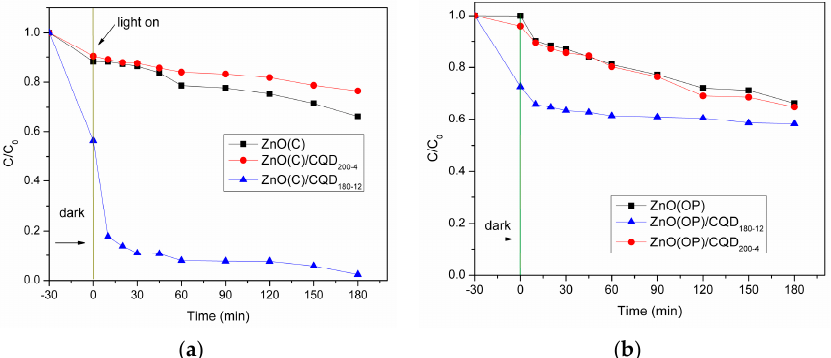
Figure 13. The degradation of MB (665 nm band) in time in the presence of ( a ) ZnO(C)/CQD and ( b ) ZnO(OP)/CQD under Vis light irradiation. According to Heng et al. [53], under irradiation with visible light, the CQDs act as a photosensitizer enlarging the absorption range of metal oxide into the visible light re- gion through electronic coupling between π states of CQDs and conduction band of the metal oxide. This corresponds to a transfer of excited electrons from CQDs to the con- duction band of the ZnO. The best results in MB degradation were obtained in the pres- ence of ZnO(C)/CQD 180-12 sample and are well correlated with the UV-vis absorption measurements results (Figure 10). In the presence of this sample, the MB conversion reached a level of 97.6%, after 180 min, while, in the presence of the pristine ZnO(C) the MB conversion was four times lower (i.e., 25%). The same level of MB conversion (26%) was registered in the presence of the ZnO(OP) sample, while onto ZnO(OP)/CQD 180-12 the decomposition of the MB reached a higher level (32%) but much lower compared to the one obtained in the presence of the ZnO(C)/CQD 180-12. Once again, the photocatalytic efficiency seems to be governed by the same factors: the CQDs and ZnO features. In the case of the ZnO(OP)/CQD samples, the self-aggregation of CQDs on the ZnO surface reduces fewer sites for activation and absorption of visible light by car- bon [60]. 3. Methods and Materials 3.1. Synthesis of ZnO/CQDs Nanocomposites Carbon quantum dots (CQDs) were synthesized following a low temperature hy- drothermal (LTH) methodology in which the humins, generated from the decomposition of glucose, were used as raw material. Briefly, 30 mg of humins were dispersed in 30 mL of water. To this suspension, 0.15 mL of glacial CH 3 COOH were added. Then, the solu- tion was placed in a Teflon-lined stainless-steel autoclave and heated at 160–200 °C for 4–12 h. After the hydrothermal treatment, the aqueous mixture was transferred into a 250 mL separating funnel and 40 mL n-butanol was added. The formed layers were vig- orously mixed thoroughly for some time, the aqueous layer, containing CQDs, was sep- arated and further analyzed. Obtained CQDs were subsequently used for the preparation of the ZnO/CQDs nanocomposites by using two methods as described below. Hydrothermal approach: In a typical procedure, 0.4 g ZnO was slowly added under stirring to a solution of 20 mL of H 2 O, 6 mL C 2 H 5 OH, and 2 mL solution of CQDs and the mixture was kept at room temperature for 4 h. The resulting suspension was then placed in a Teflon-lined stainless-steel autoclave and kept at a constant temperature of 140 °C for 4 h. After hydrothermal treatment, the ZnO/CQDs product was collected by centrifugation, washed with deionized water several times to remove the impurities and